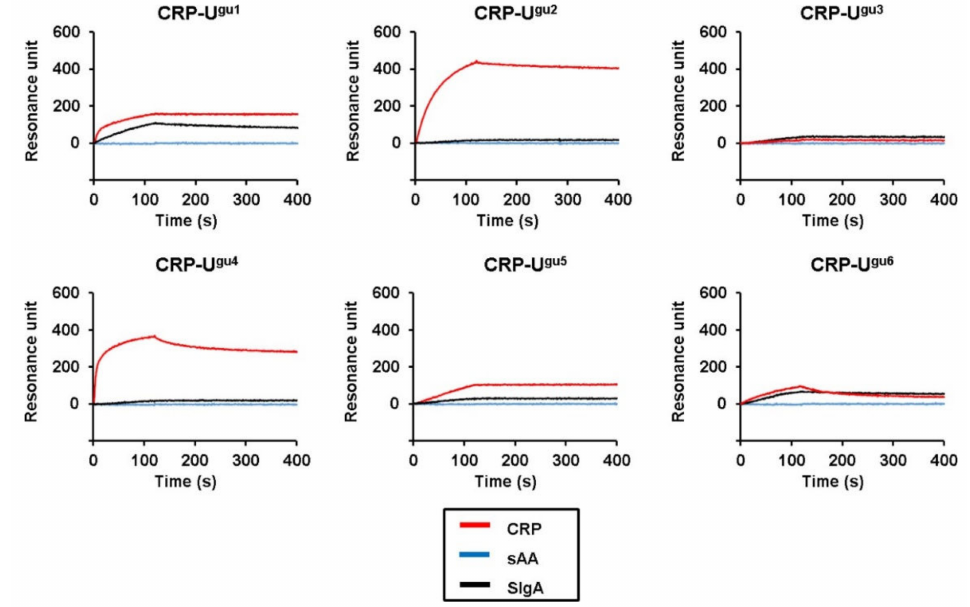
Figure A2. SPR response curve of the interaction between either CRP or the salivary proteins SIgA and sAA, and the candidate aptamers CRP–U gu1 , U gu2 , U gu3 , U gu4 , U gu5 , and U gu6 . CRP, SIgA, or sAA (400 nM each) were injected over the respective aptamer-immobilizing sensor chips for 120 s at a flow rate of 50 µ L / min. The red line represents the CRP measured curve, while the blue and black lines represent the sAA and SIgA recorded curves,